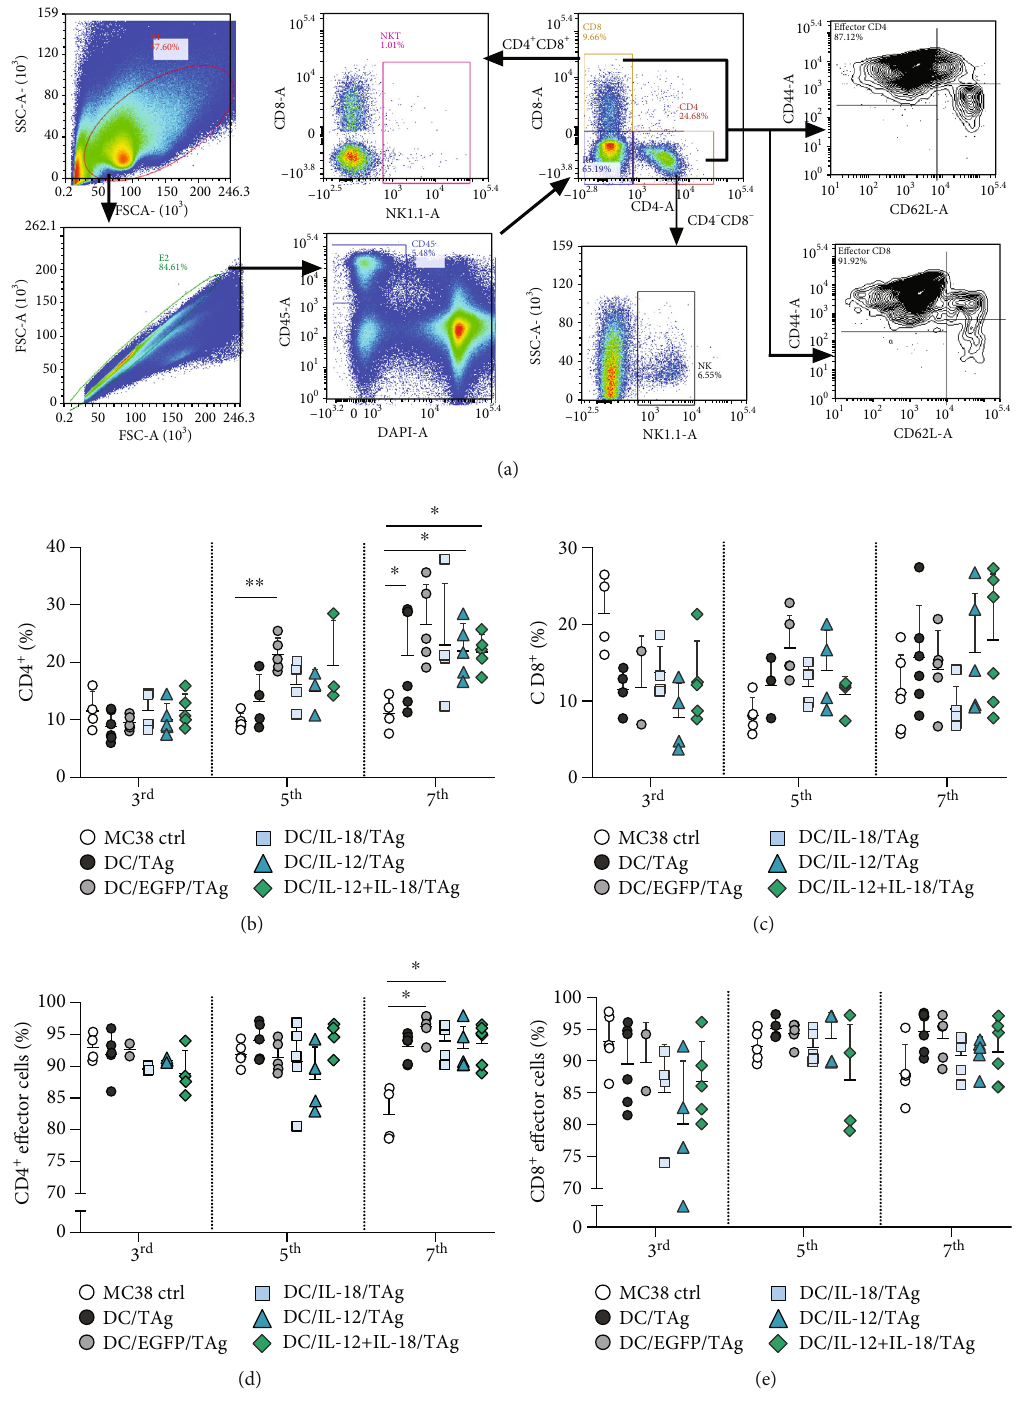
Figure 6: Evaluation of lymphoid cell subpopulation in fi ltrating the tumor tissue after administration of DC-based vaccines. (a) Scheme of the multiparameter fl ow cytometric analysis of CD4 + and CD8 + T cells, NK and NKT cells, and T lymphocyte activity. The analysis was started by eliminating debris and cell aggregates; then, live leukocytes (DAPI - CD45 + ) were gated, including CD4 + T cells and CD8 + T cells. NKT cells were identi fi ed among CD4 + CD8 + cells, while NK cells were extracted from the CD4-CD8- cells, based on NK1.1 marker expression. E ff ector T lymphocytes were de fi ned as CD44 + CD62L - . (b, c) Percentage of CD4 + and CD8 + T lymphocytes among CD45 + cells in tumors on the 3rd, 5th, and 7th days after DC injection. (d, e) Percentage of e ff ector cells among CD4 + and CD8 + T cells in tumors. Results are presented as mean ± SD calculated for 5-6 mice per group. Di ff erences between groups were estimated using the parametric Brown-Forsythe and Welch ANOVA test followed by Dunnett ’ s T3 multiple comparison post hoc test ((b) percentage of CD4 + on the 5th and 7th days; (d) percentage of CD4 + e ff ector cells on the 7th day) ( ∗ p < 0 : 05 , ∗∗ p < 0 : 01